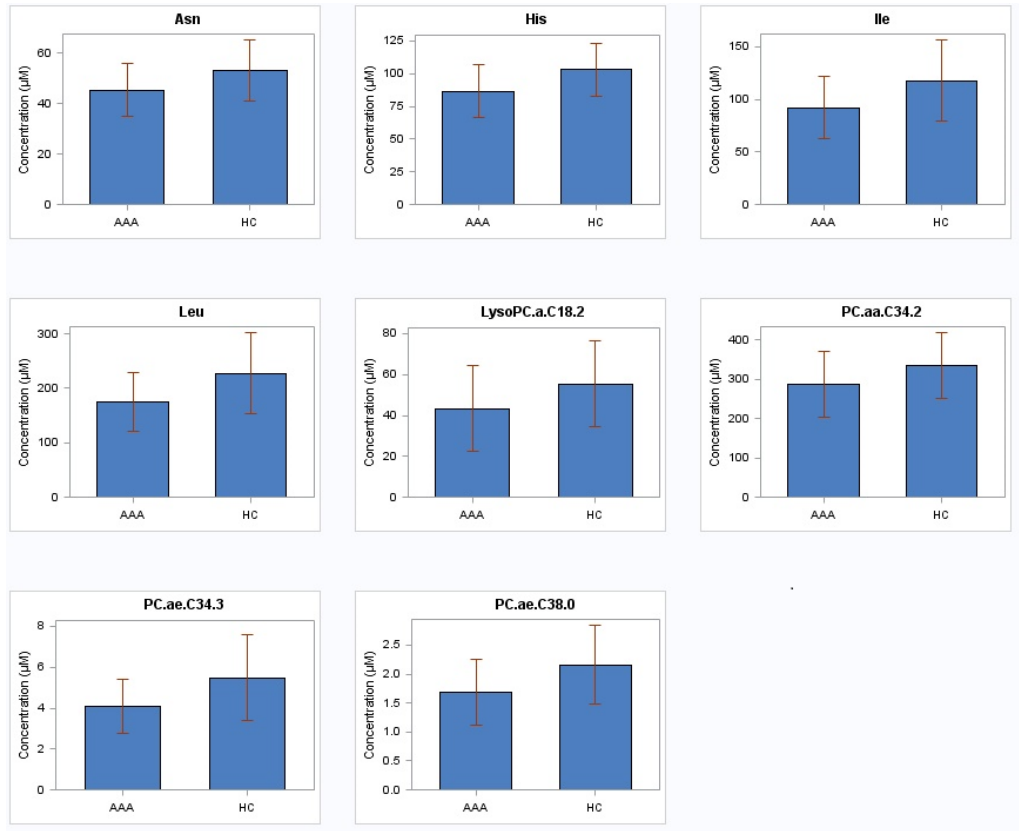
Figure 1. Amino acids and phosphatidylcholines in plasma from 79 patients with abdominal aortic aneurysm and 79 healthy subjects with non-aneurysmal aorta. AAA abdominal aortic aneurysm; HC healthy controls; His histidine; Asn asparagine; Leu leucine; Ile isoleucine; PC.ae.C34.3 phosphatidylcholine acyl-alkyl C34:3; PC.aa.C34.2 phosphatidylcholine diacyl C34:2; PC.ae.C38.0 phosphatidylcholine acyl-alkyl C38:0; LysoPC.a.C18.2 lysophosphatidylcholine acyl